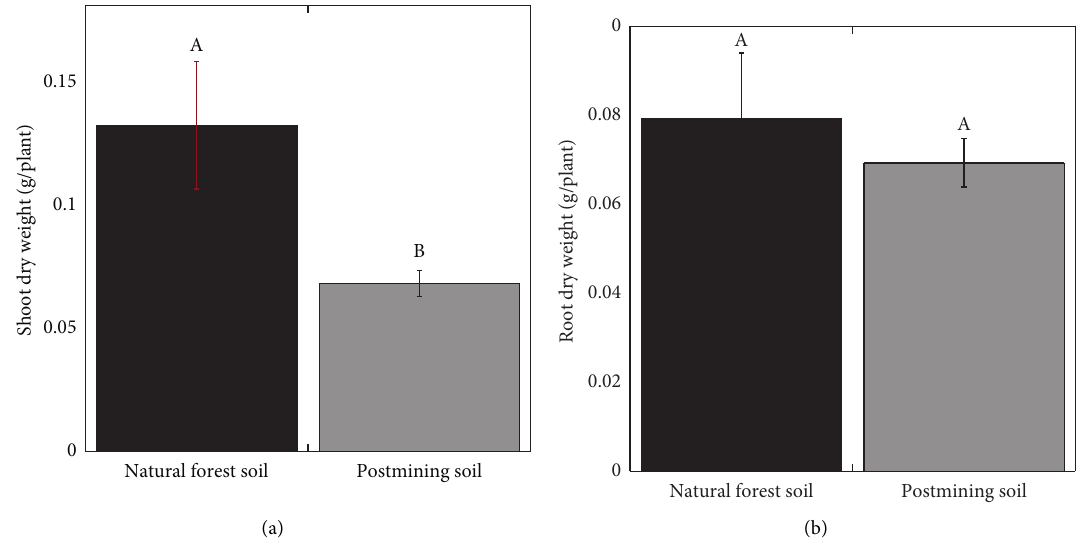
Figure 3: Mean shoot (a) and root (b) dry weight of Falcataria moluccana 15 weeks after planting in soil from post-nickel mining land and natural forest. Different letters indicate significant differences ( P � 0 . 05). Error bars indicate standard error ( n � 15).